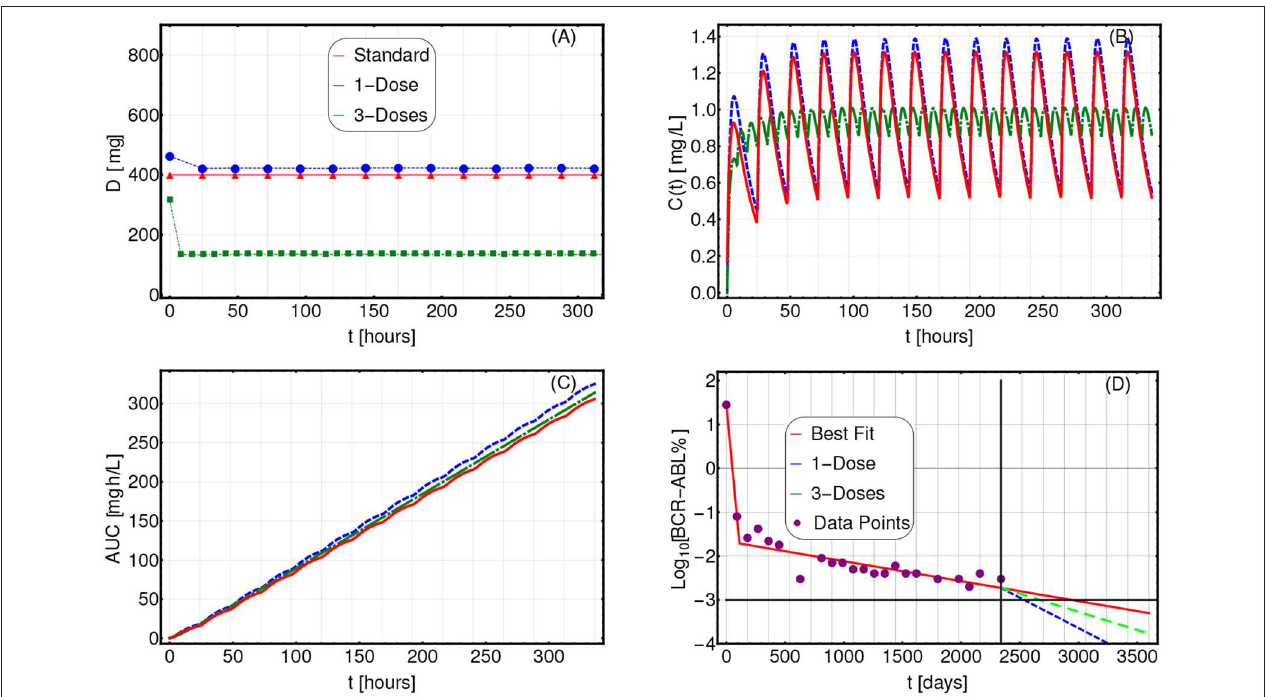
FIGURE 6 | Adjusting therapy for tumor burden minimization. Imatinib administration optimized for tumor burden minimization in patient 0001 00004 AJR (male) from Michor et al. (2005), in the cases of: 1-dose/day (purple) and 3-doses/day (green), with φ = 60, as compared to standard administration (red). In this case, the optimization is obtained on patient-specific PK and PD models. (A) Imatinib scheduled dosage in mg (y axis), displayed on 14 days (x axis). (B) Imatinib concentration in blood in [ mg / L ] (y axis). (C) Temporal variation of the AUC in [ mg · h / L ] (y axis). (D) Longitudinal data points on tumor burden recorded in the interval t ∈ [0,2340] days (purple). The best fit is shown with red lines. The slope of the right-most line is used to determine the cancer stem cell death rate and, in turn, the patient-specific PD parameters. The blue (green) line represents the predicted cancer subpopulation decay in case the 1-dose (3-doses) optimized therapy was adopted from day 2,340 to day